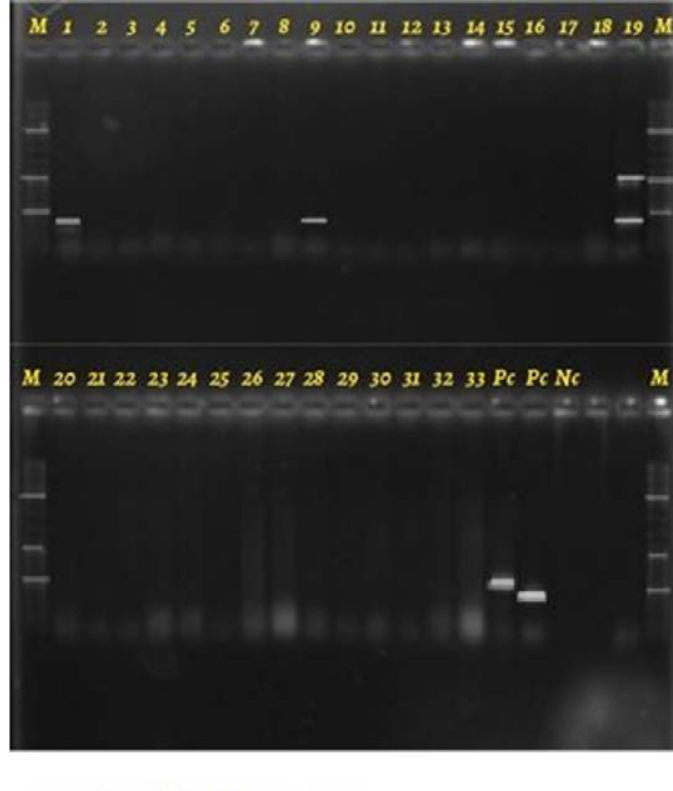
Fig. 2. Multiplex PCR conducted on Klebsiella clinical isolates run as positive and negative